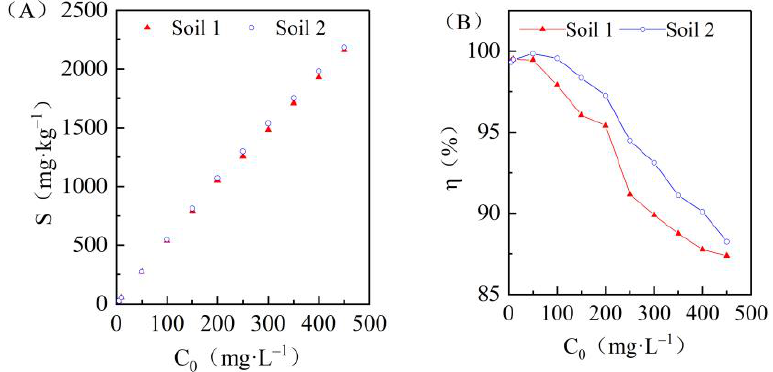
Figure 2. Changes in adsorption capacity S ( A ) and adsorption rate η ( B ) with the initial concentration of solution C 0 in the two soils.